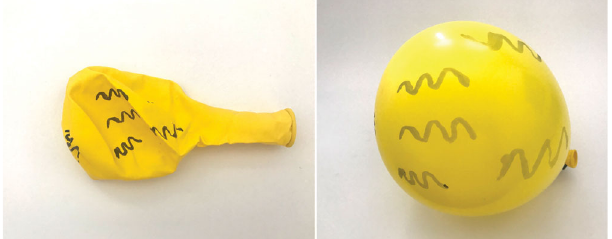
FIG. 26. Expanding balloon wavelength analogy. Here the aim is to communicate the concept that the wavelength of light stretches as the result of space expanding — cosmological red- shift. Keen observers would highlight that the wavelength is not actually getting longer, rather the entire waveform is getting larger. Once again, the limit of analogies requires teacher scaffolding. Image credit: Saeed